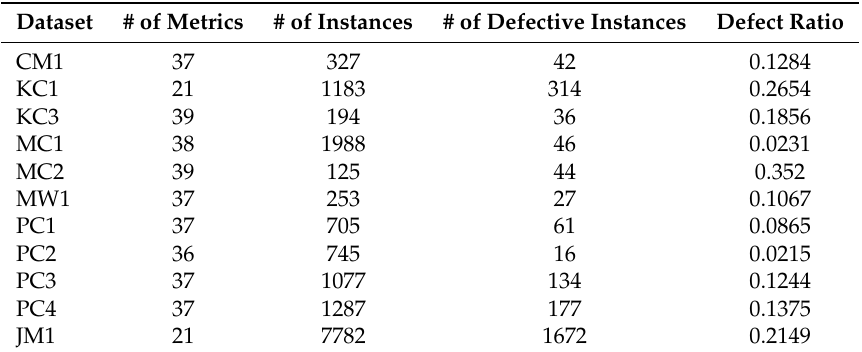
Table 1. Statistics of 11 cleaned NASA datasets used in this